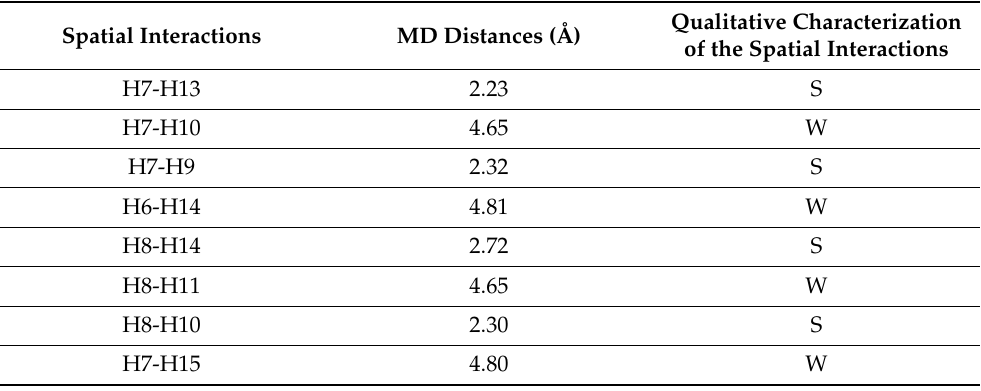
Table 3. The most important comparative distances in the complex obtained through 2D NOESY and DFT MD calculations for KKI15 (top) and KKI18 (bottom).